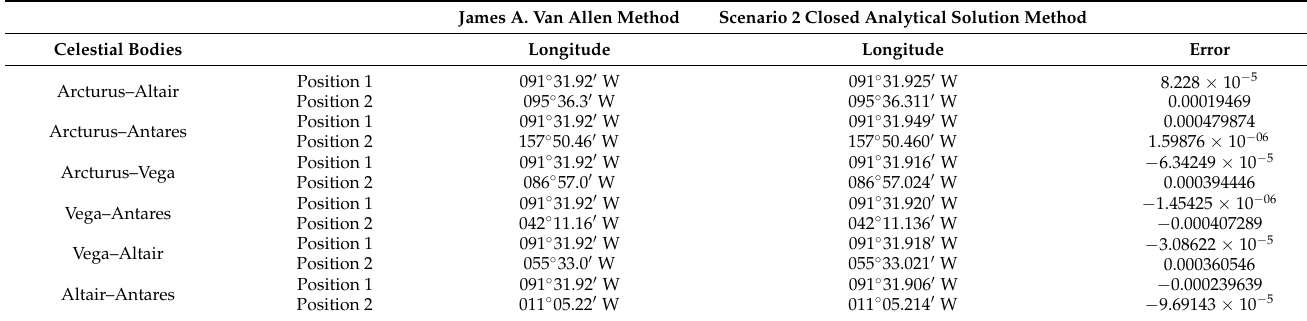
Table 9. Longitude errors of the two positioning